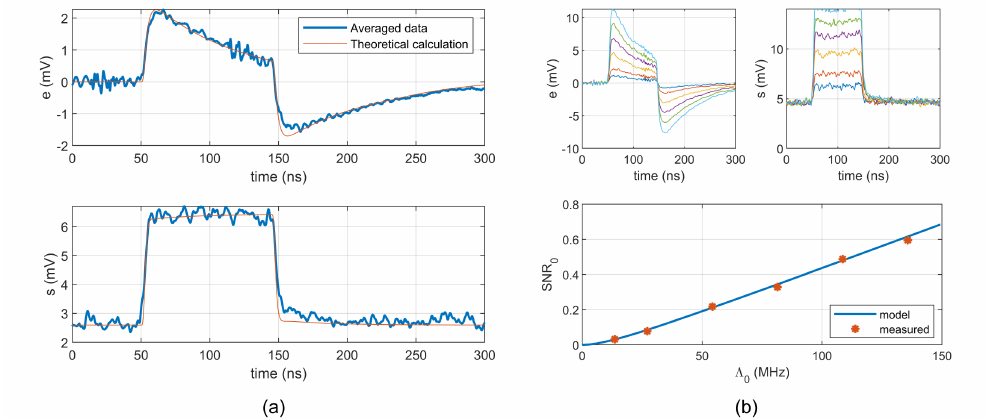
Figure 13. Statistical processing of recorded signals: ( a ) Estimation of e ( t ) and s ( t ) for λ 0 = 5.54 MHz and Λ 0 = 27.7 MHz computed from 9998 records. ( b ) Estimation of SNR 0 for different pulse